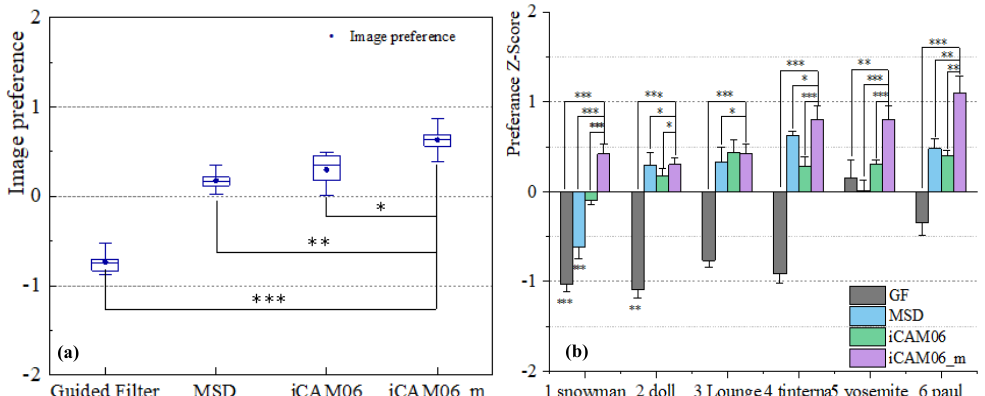
Figure 5. Subjective evaluation results. ( a ) Results of four algorithms for the compression performance in image preference. T -test was conducted for the difference between the proposed algorithm and other three TMOs. * indicates 𝑝 < 0.05 , ** indicates 𝑝 < 0.01 , *** indicates 𝑝 < 0.001. ( b ) Results of four algorithms of each image for the compression performance in image preference. The error bars denote 1 standard deviation. The significance difference between the proposed algorithm and other three TMOs, including each image, is calculated.